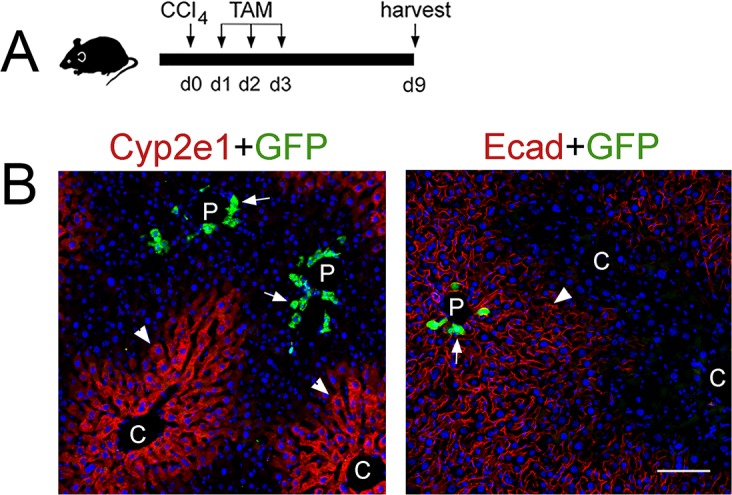
Sox9+ hepatocytes do not contribute to Zone 2/3 restoration after CCl4 induced acute liver injury.(A) Schematic of CCl4 administration and tissue harvesting. (B) Double-immunofluorescence showing expression of the lineage tracer GFP (arrows) in hepatocytes surrounding the portal veins (P) and located in Zone 1 (E-cadherin+, arrowhead, right). GFP is not expressed in the restored Zone 2/3 (Cyp2e1+, arrowheads, left) up to 9 days after CCl4-induced injury. Scale bar: 100 μm.